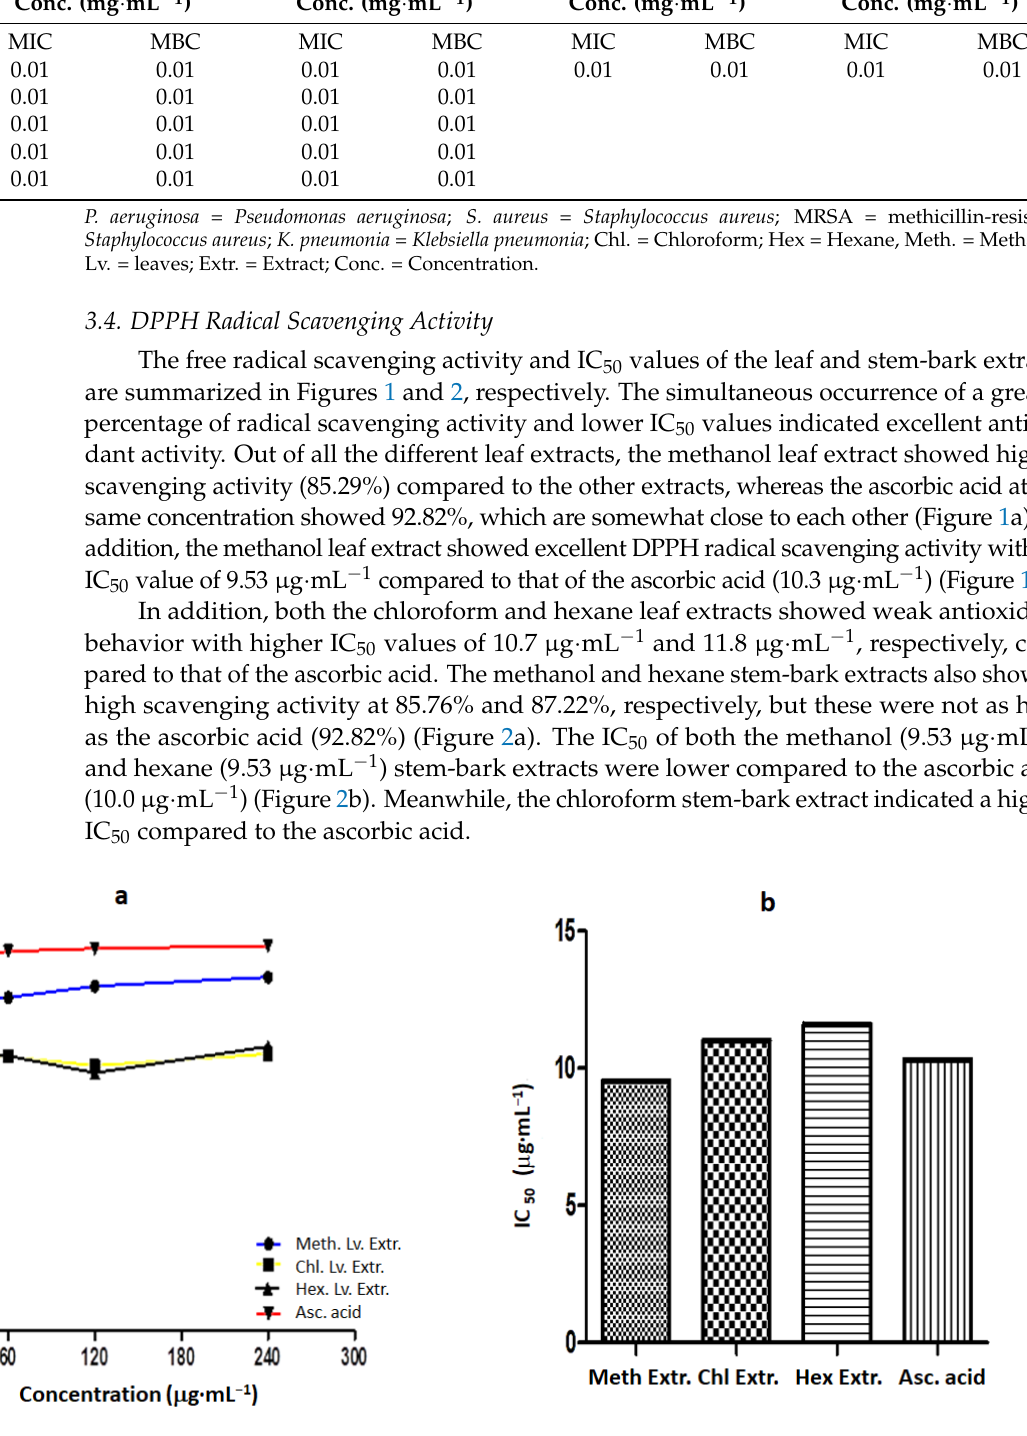
Figure 1. Comparison of DPPH radical scavenging ( a ) IC 50 values of D. villosa (%) of D. villosa leaf extracts in DPPH scavenging assay ( b ). Chl = Chloroform; Hex = Hexane, Meth = Methanol; Lv. = leaves; Extr. = Extract.